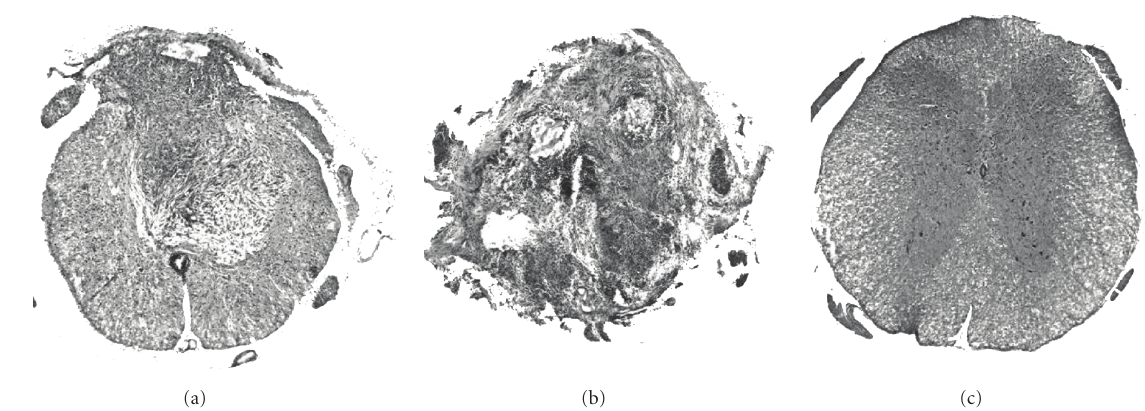
Figure 2: HE staining of representative axial spinal cord sections from the three groups of mice. (a) Contusion model: the ventral part of the spinal cord tissue was preserved, whereas the dorsal part was replaced by fibrous scar tissue after SCI. (b) Transection model: normal structure of the spinal cord totally disappeared. (c) Control